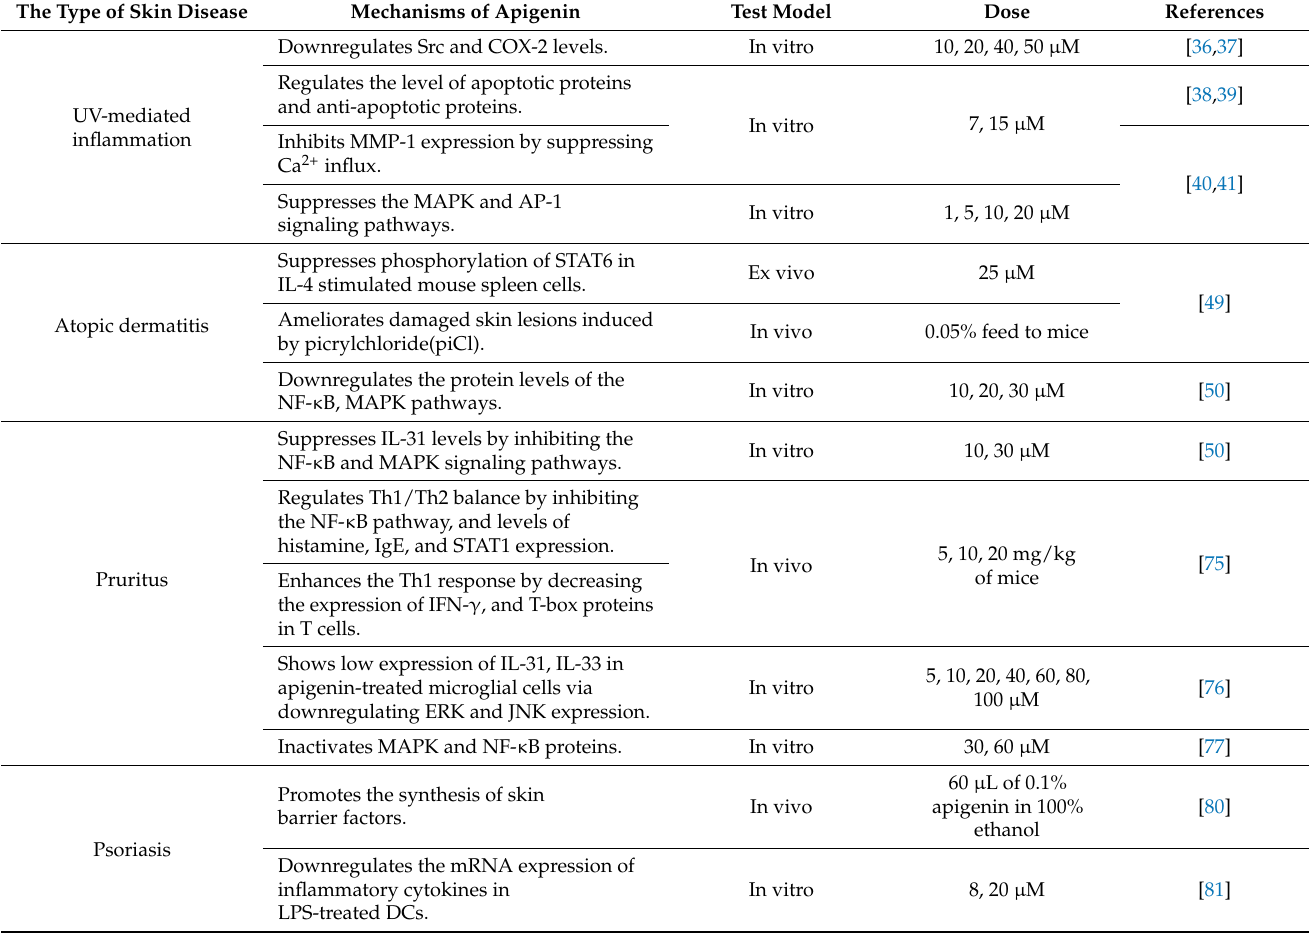
Table 2. Mechanism of apigenin against inflammatory skin diseases and